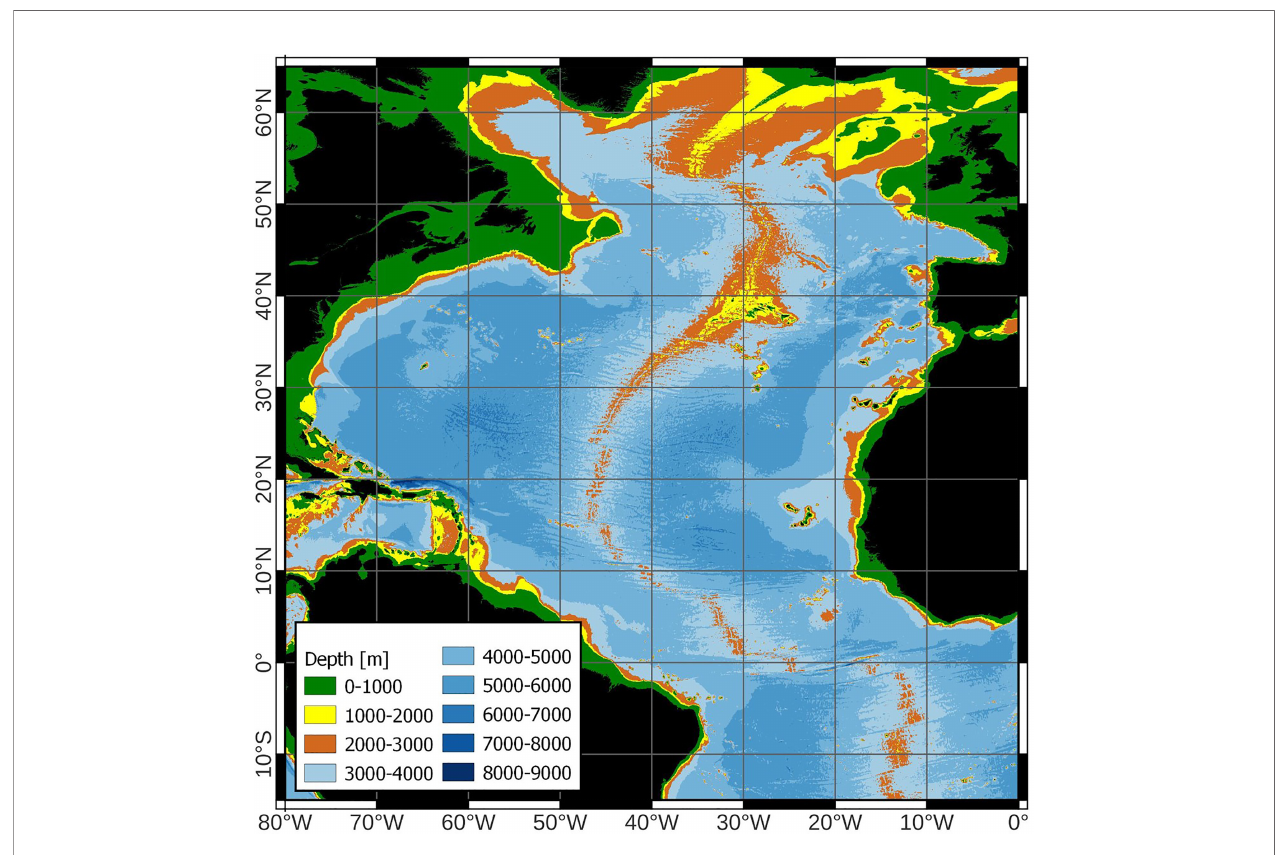
FIGURE 1 | Chart of the North Atlantic Ocean showing the Mid-Atlantic